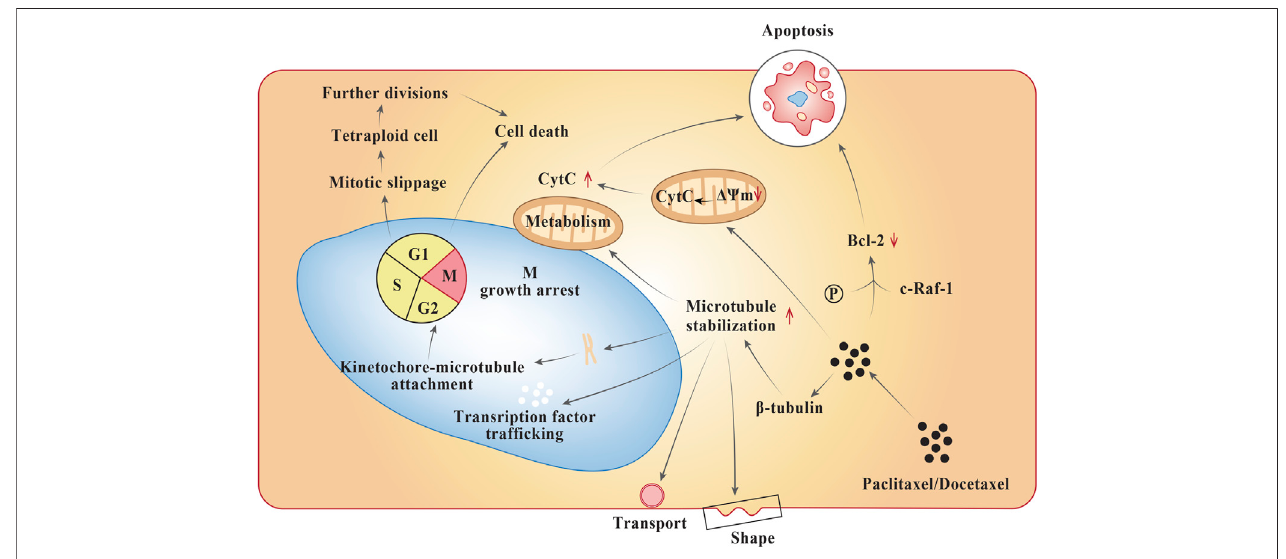
FIGURE 1 | Mechanism of action of taxanes in neoplastic